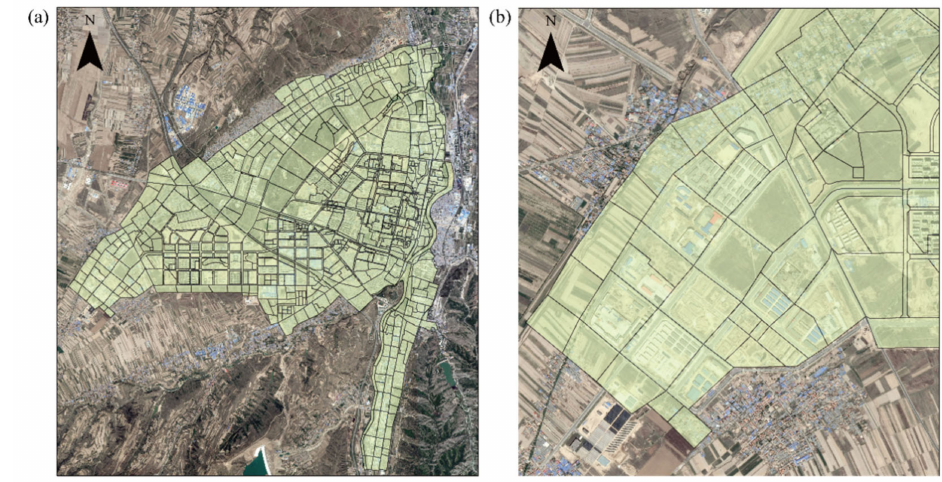
Figure 4. The sub-catchment area. ( a ) All sub-catchment areas; ( b ) local sub-catchment area.